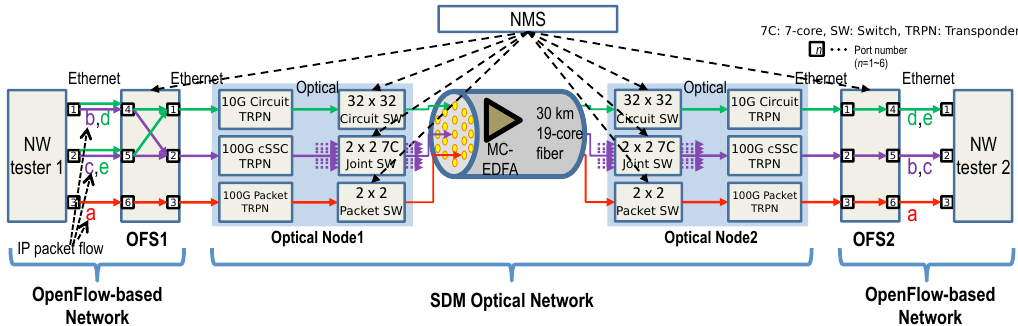
Figure 8. Experimental setup for the SDM testbed for optical channel selection through quality of service (QoS).